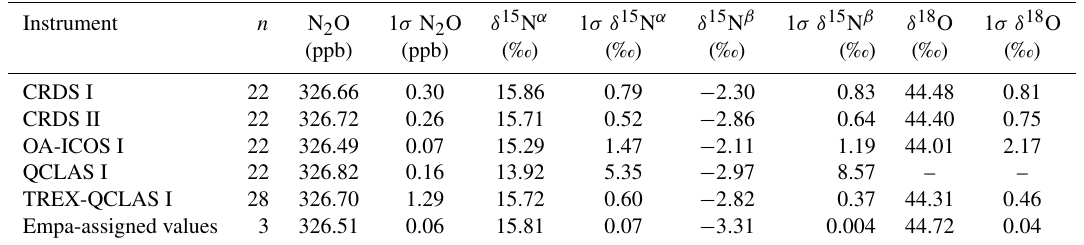
Figure 4. Examples of the dependency of different measurements on laboratory temperature ( ◦ C) for OA-ICOS I (blue), CRDS I (red), CRDS II (black) and QCLAS I (green). The complete dataset is provided in Sect. S4 (Fig. S4-2). The laboratory temperature is indicated by a solid orange line and was allowed to vary over time. Cell temperatures for each instrument are also plotted for comparison. The analyzers began acquiring measurements at 00:00CEST on 8 July 2018, capturing the end of the rising limb of the laboratory temperature. Results are plotted as the deviation from the mean, without any anchoring to reference gases. Table 7. Summary of the measured [ N 2 O ] , δ 15 N α , δ 15 N β and δ 18 O and associated 1 σ at 300s averaging times based on repeated measure- ments of